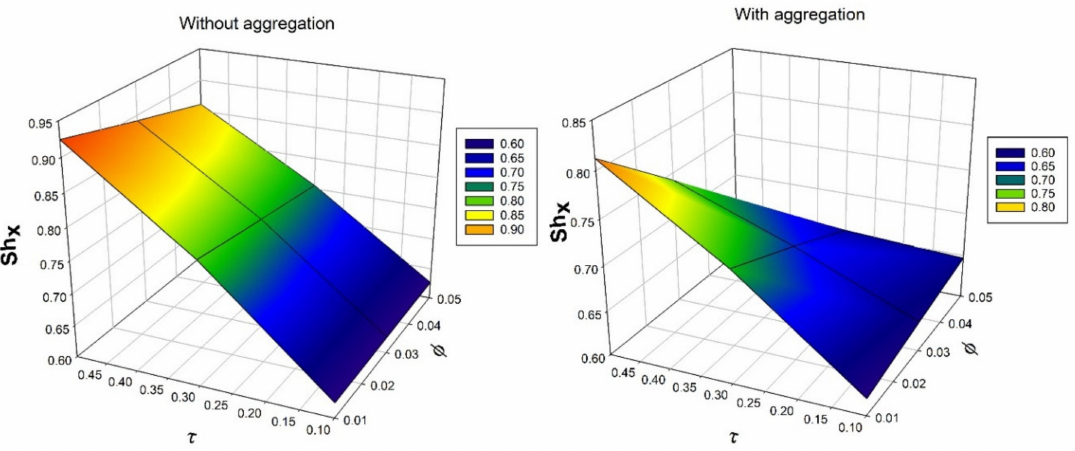
Figure 10. Nature of Sherwood number ( Sh x ) over solid volume fraction ( φ ) for numerous values of thermophoretic parameter ( τ ) .